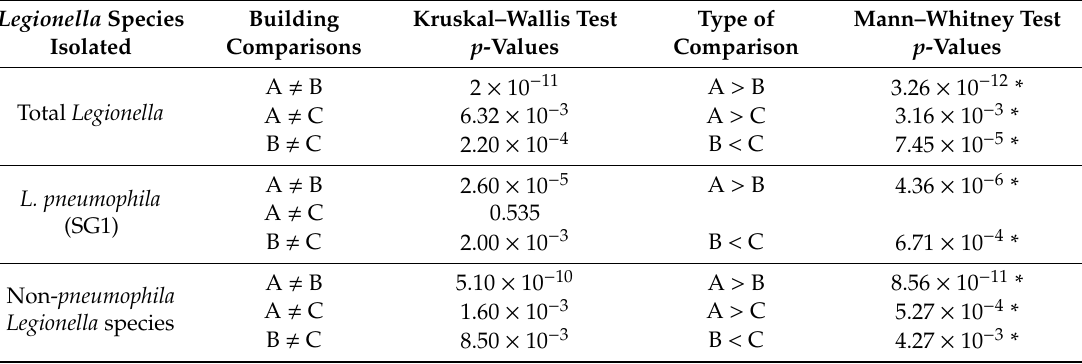
Table 2. Comparison of mean Legionella concentration between